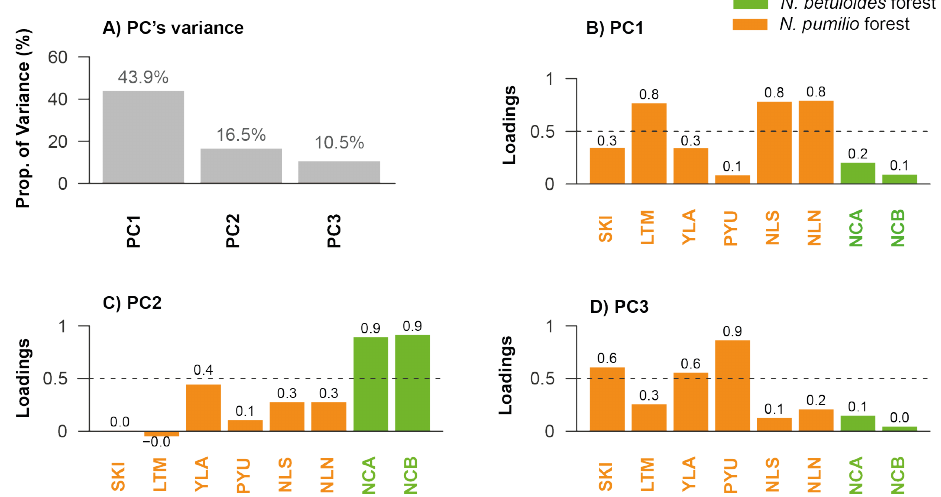
Figure 4. Results of the Principal Component Analysis (PCA) of all eight Nothofagus spp. chronologies over the common period 1895–2019. ( A ) PC variance explained by the first three principal components (grey boxes). ( B – D ) Loading values of each site in PC1, PC2, and PC3, respectively.